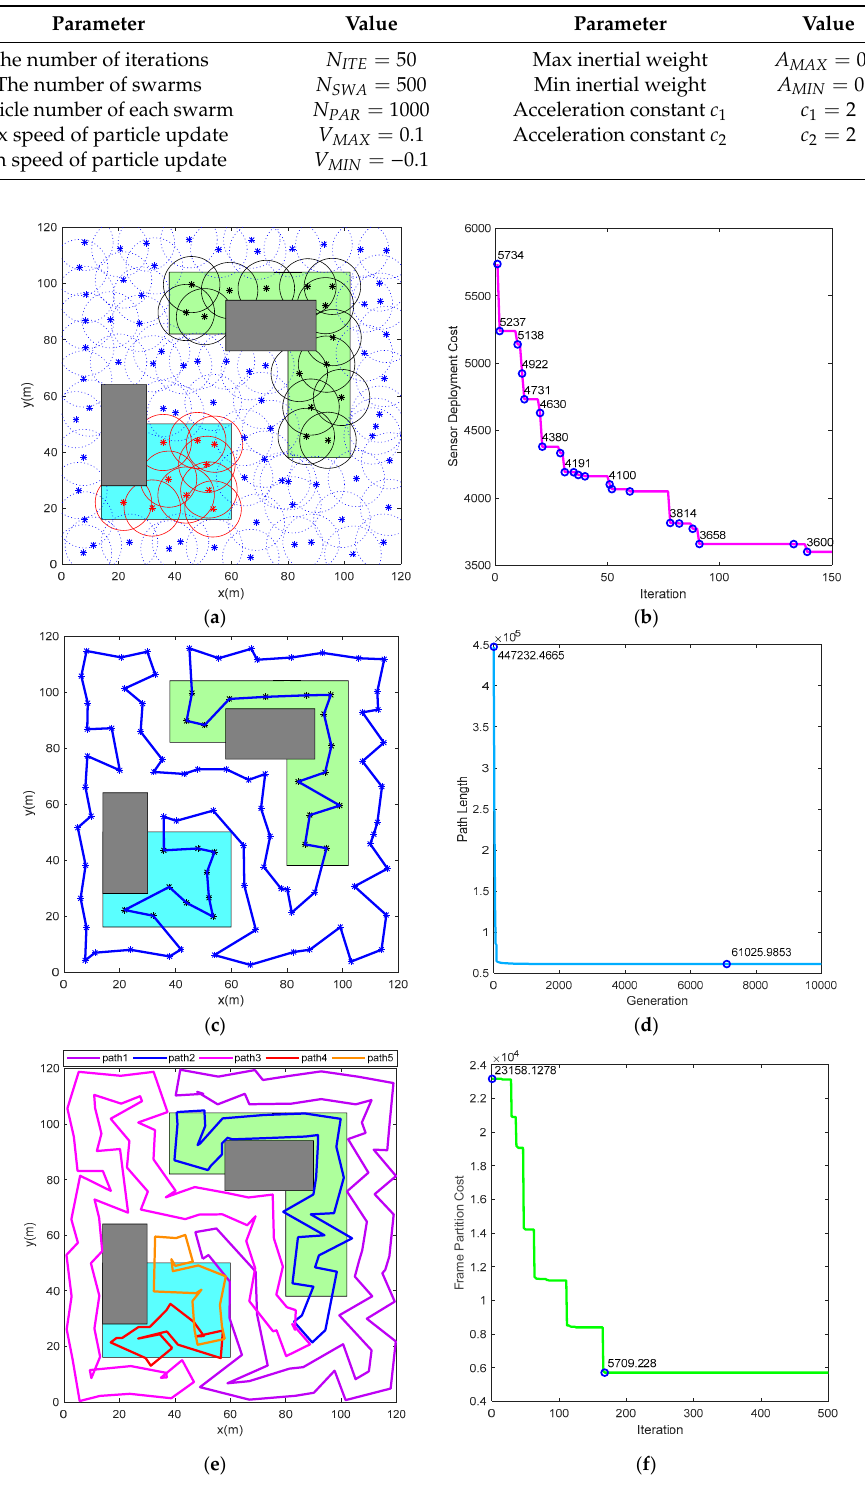
Figure 13. Simulation results under parameters in Tables 2, 3, and 4. ( a ) Sensor deployment for complete coverage; ( b ) Sensor deployment cost; ( c ) Path planning result; ( d ) The changing process of path length; ( e ) The closed route for each robot; ( f ) Frame partition cost.